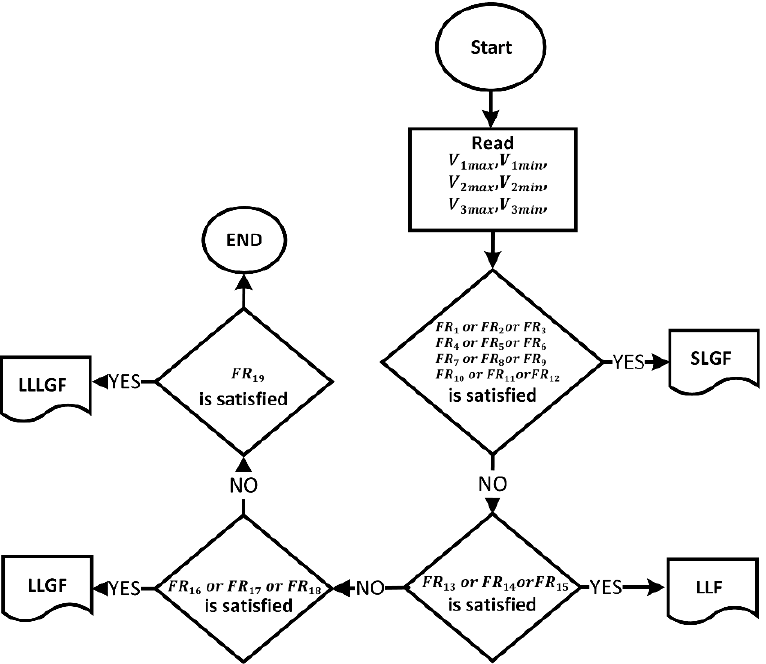
Figure 3. Flow diagram of the scoring algorithm.